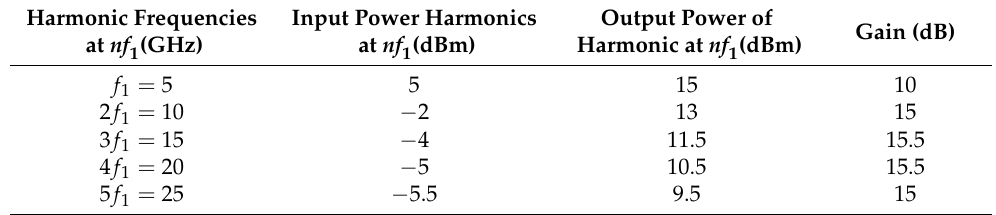
Table 2. The conversion gain for the amplified OPS field at the exit of the SOA-MZI at nf 1 . Harmonic Frequencies Input Power at nf (GHz) 1